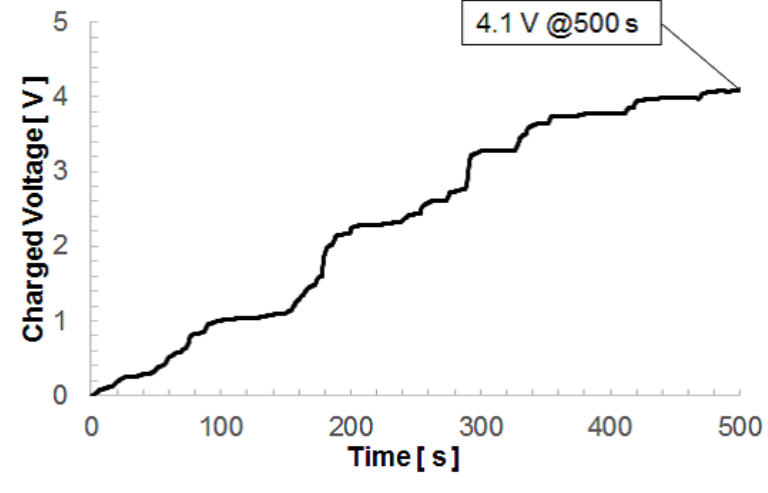
Figure 12. Charging voltage increment to the 44 µ F capacitance obtained by the acceleration of the viaduct of a highway.